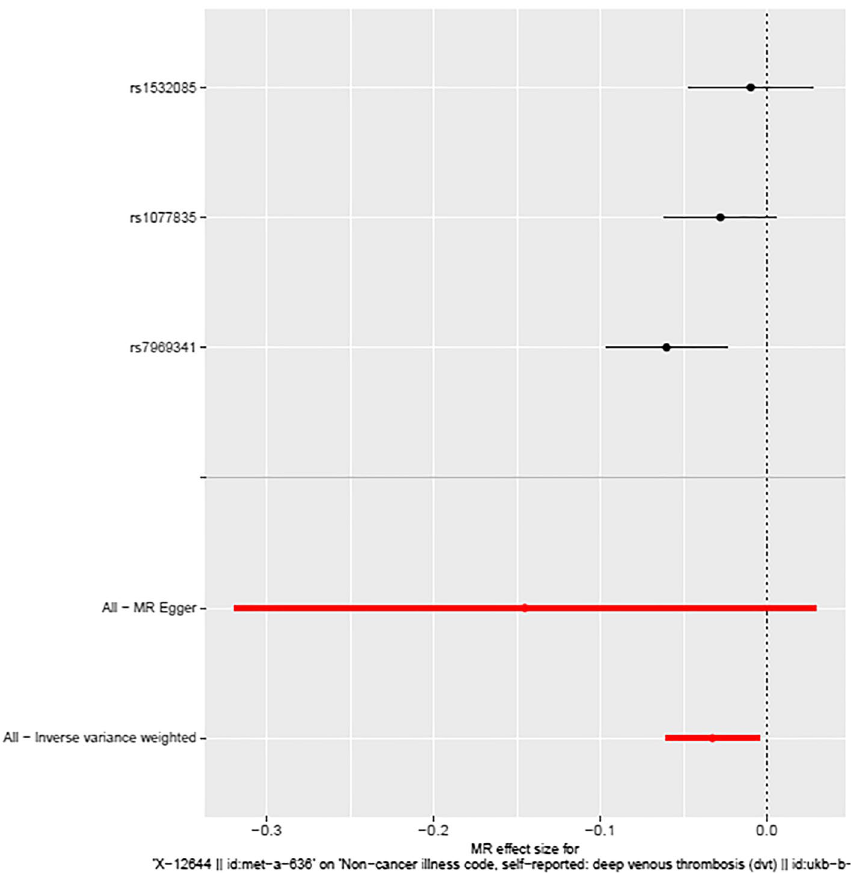
Figure 3. Forest Map of causality between X-12644-related SNP and DVT. The causal effect of exposure on outcome is estimated using each SNP singly using the Wald ratio, and represented in a forest plot. The MR estimate using all SNPs using the MR Egger and IVW methods are also